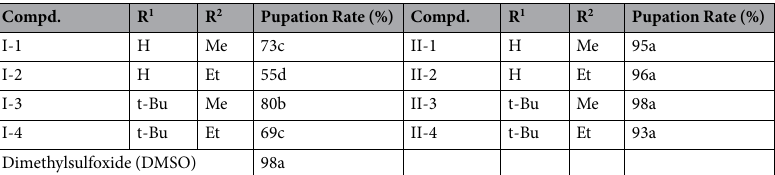
Table 2. Pupation rate of S . litura after treatment for 14 days * . * From 5 replicates, each replicate contained 20 test insects. Data followed by the different letters means significant difference ( P < 0.05, method of Duncan’s Multiple Range Test). The pupation rate is calculated using the following formula: pupation rate (%) = (1 – n / N ) × 100, where n is the number of pupated insects, N is the total number of test